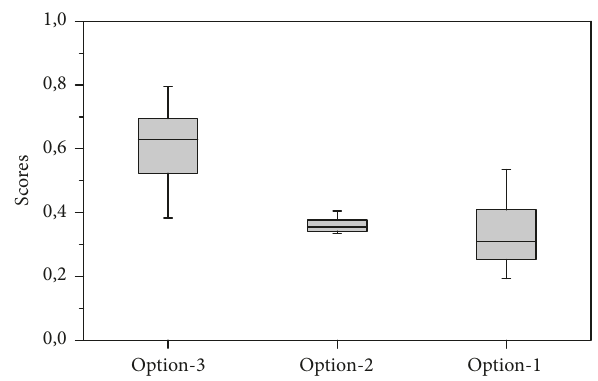
Figure 6: Ranking of options taking into account the uncertainties in the weights using the box-and-whisker chart (95th, 75th, 50th, 25th, and 5th